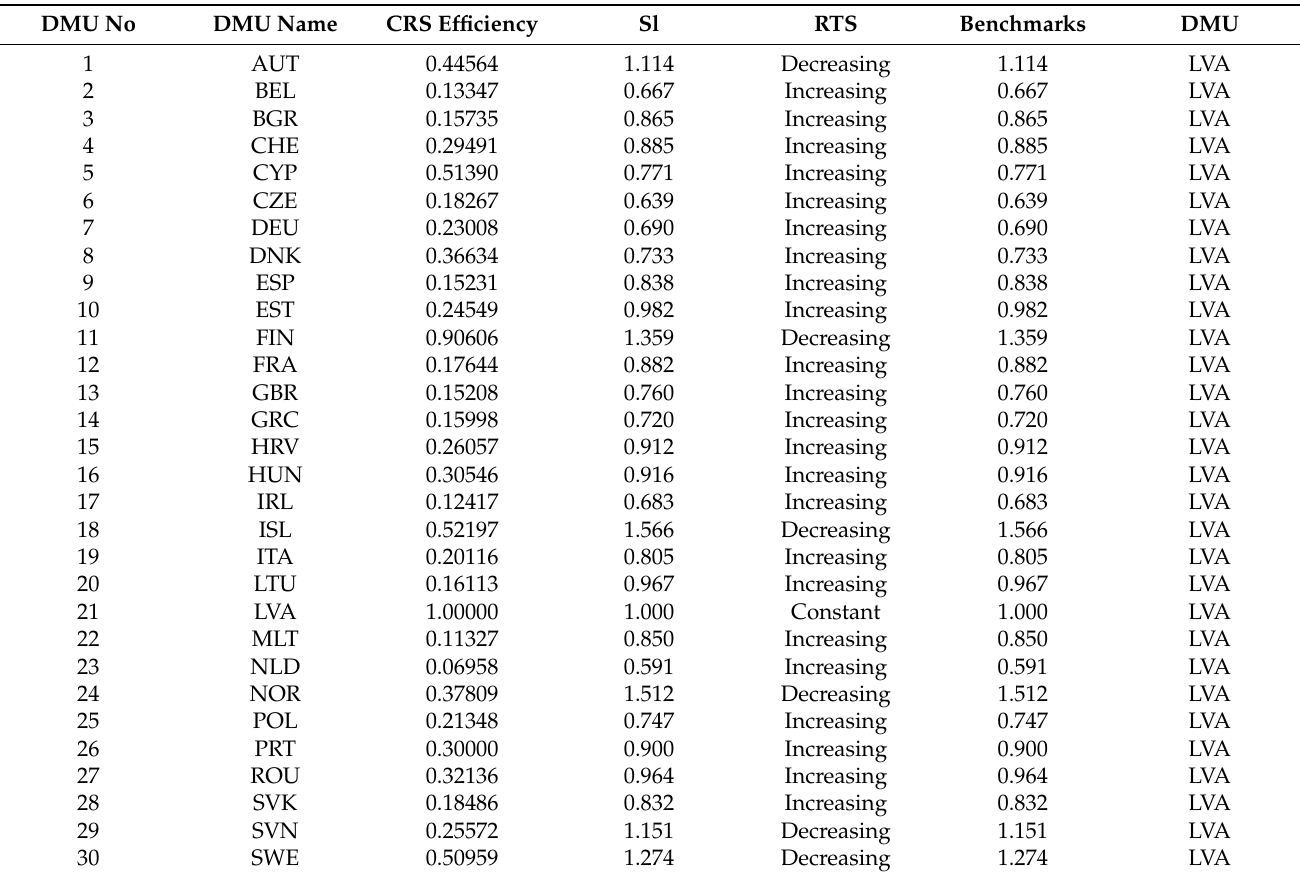
Table A11. Input-Oriented CRS Efficiency of EPS in 2009. Source: Authors’ calculations in DEAFrontier.